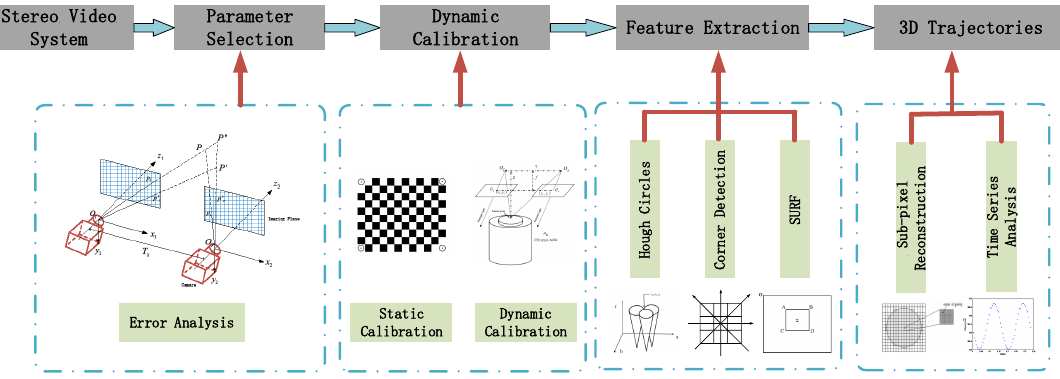
Figure 1. The procedure to identify 3D unbalance